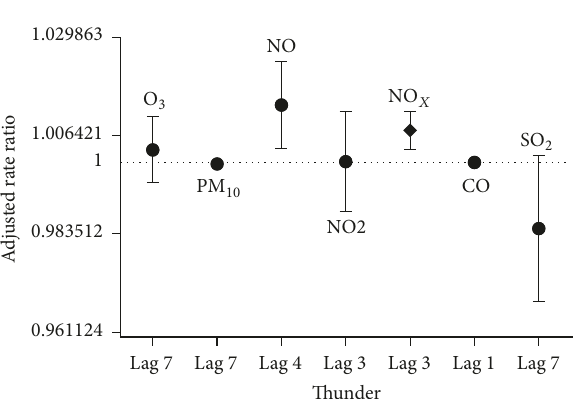
Figure 5: Strongest correlations between air pollutants and hospital admissions for asthma and bronchospasm happening up to 7 days later in epidemic